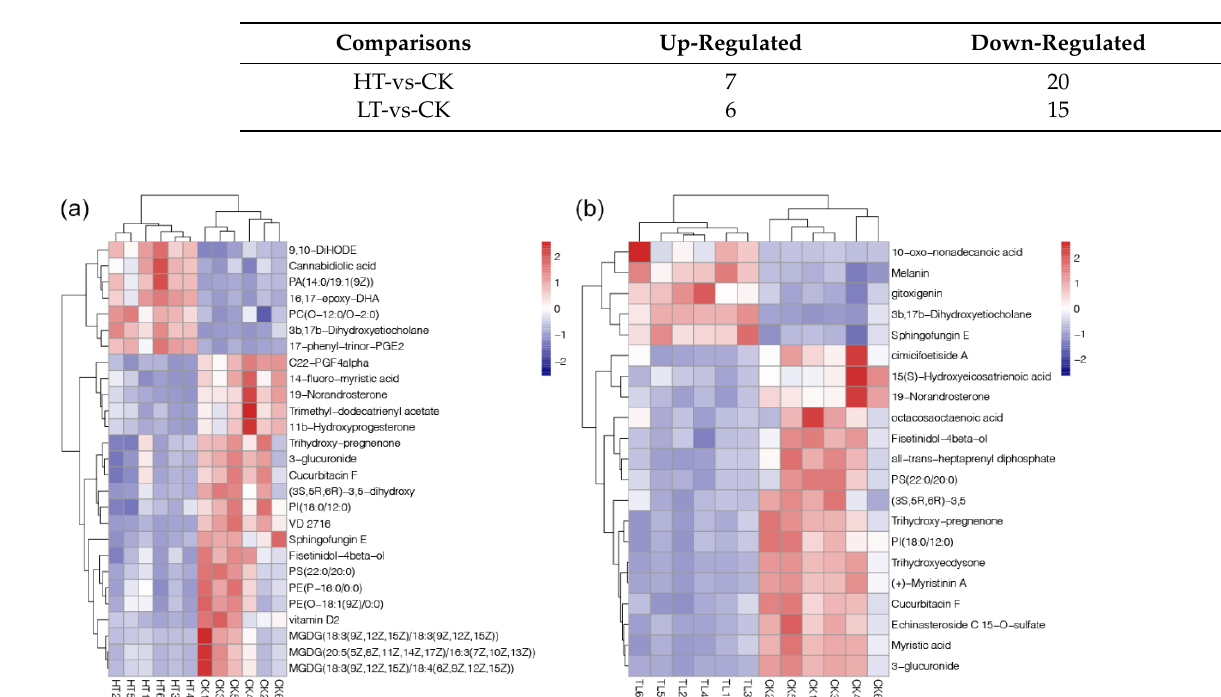
Table 1. The numbers differentially abundant metabolites in corals under different temperature stresses.